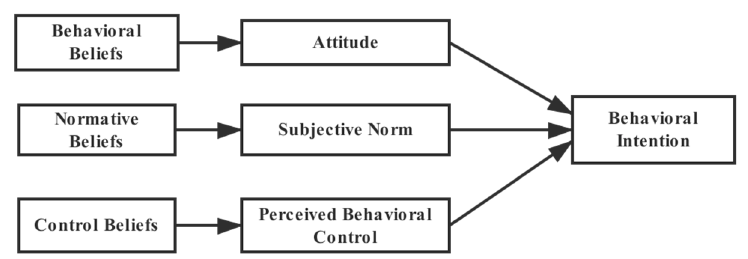
Figure 1. Theory of Planned Behavior Diagram (Reproduced with permission from [33], Elsevier, 1991).